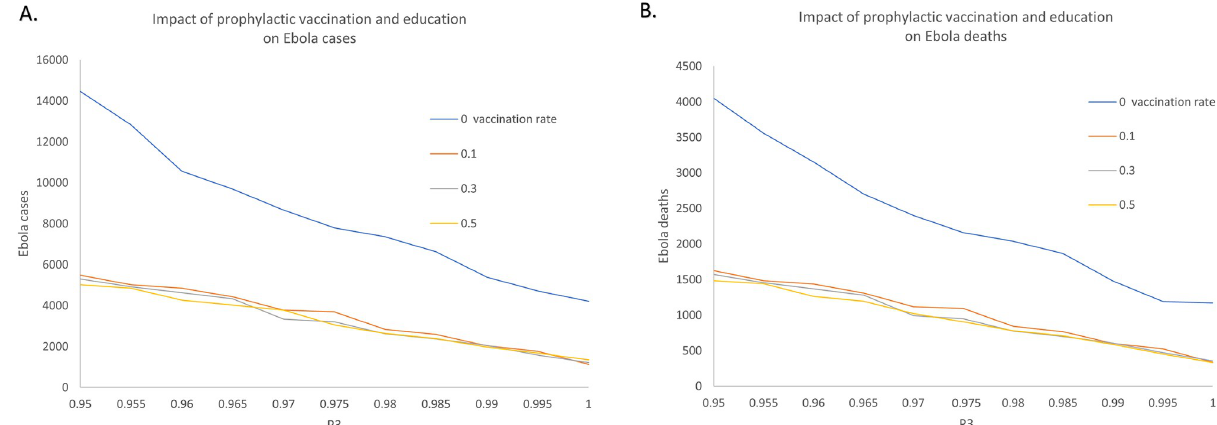
Fig 9. Impact of combined interventions on cumulative Ebola cases and deaths. The combined intervention refers to combination of education and vaccination strategies. A: Cumulative cases. B: Cumulative deaths.